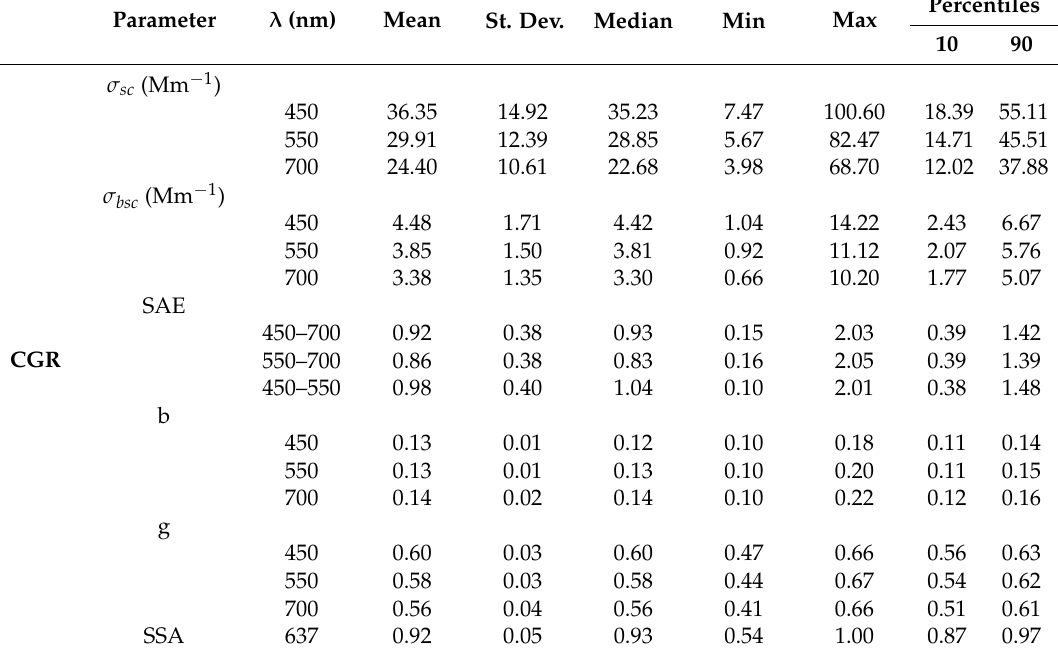
Table 1. Statistical properties (from 5 min average) of the measured and calculated optical properties over the whole period analysed for the CGR